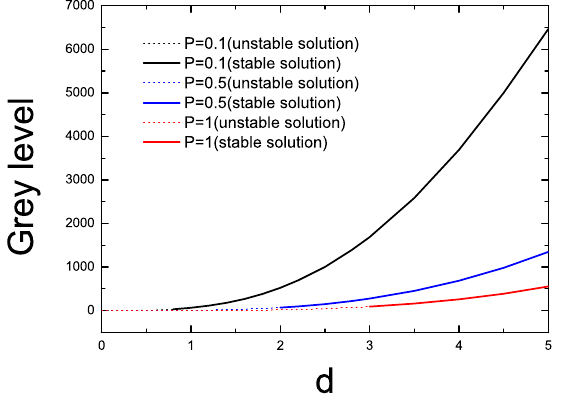
Figure 4. Grey levels of grey solitons with different d and P